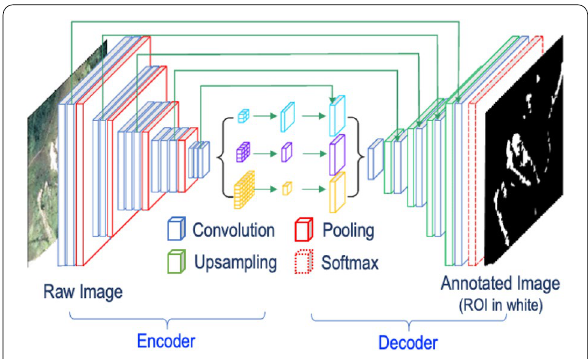
Figure 9 Structure of U-Net, adapted from Ref.